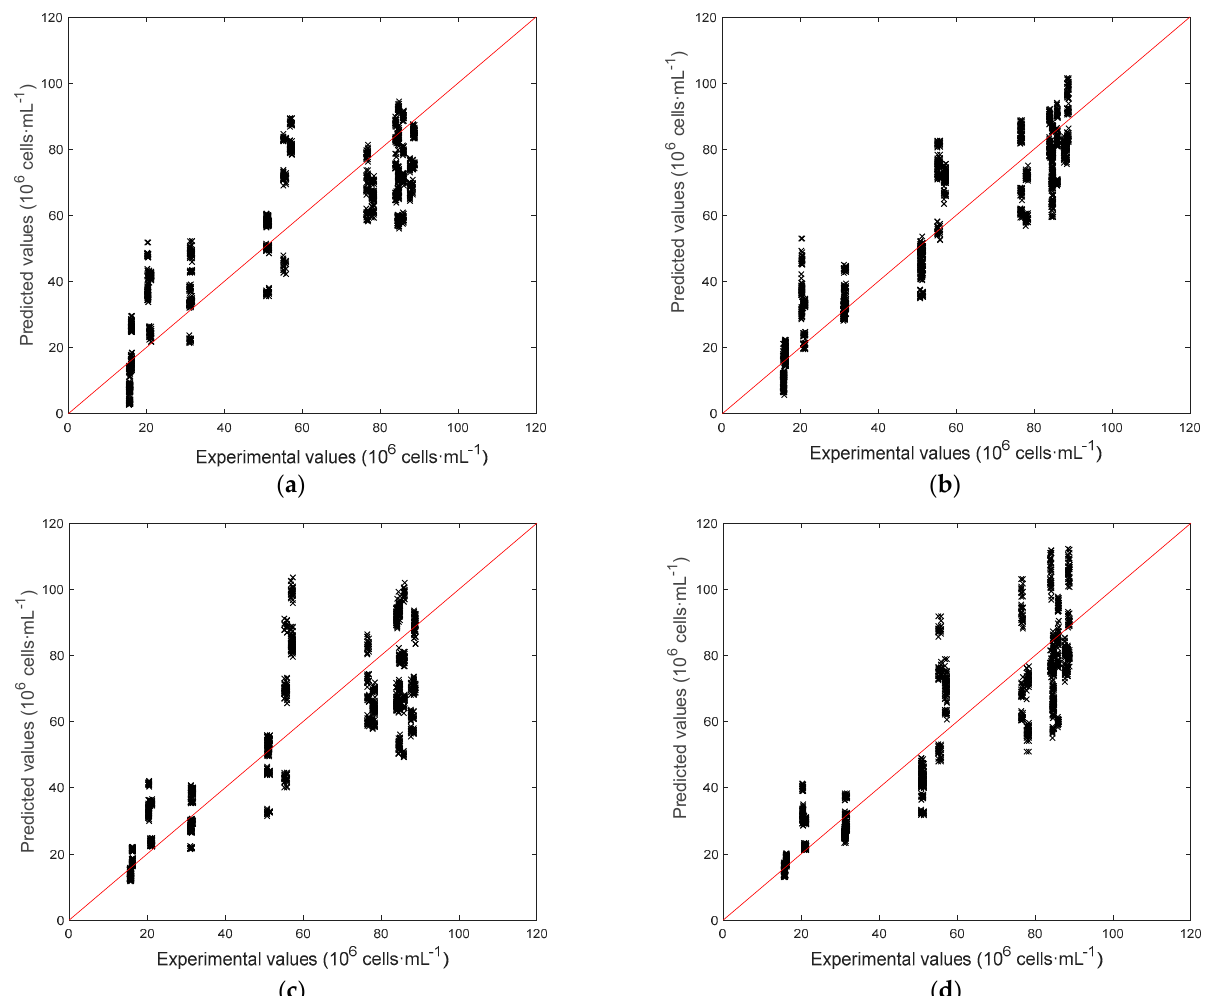
Figure 8. Parity plots for the models predicting the biomass concentrations. ( a ) C[ X CI (cid:107) C x ], SSR = 30.43. ( b ) C[ X CI | X FI (cid:107) C x ], SSR = 16.08. ( c ) C[ X CI (cid:107) ln(C x )], SSR = 22.33. ( d ) C[ X CI | X FI (cid:107) ln(C x )], SSR = 14.05.